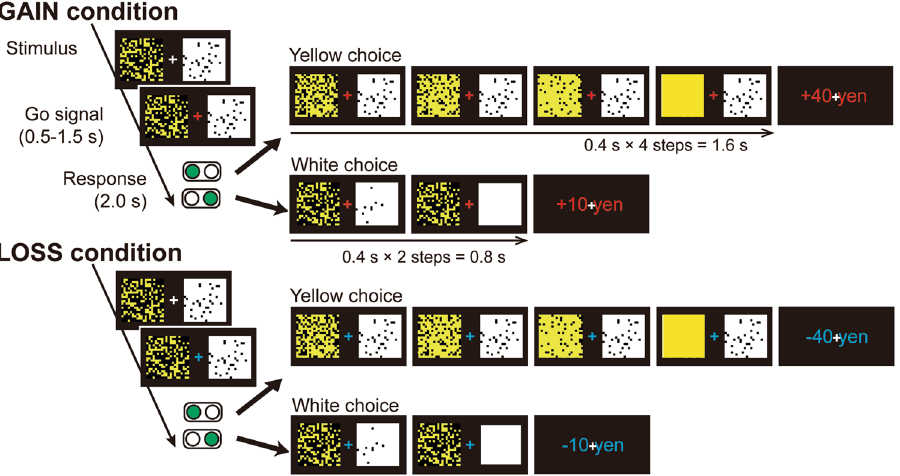
Figure 1. Participants were asked to select either a white or yellow square by pressing a button on the corresponding side. In the example shown, if the participant chose a white square at each step, a small monetary gain (10 yen) in the GAIN condition or a small monetary loss ( − 10 yen) in the LOSS condition was delivered in two steps (0.4 × 2 = 0.8 s). If the participant chose a yellow square, four yellow choices (0.4 × 4 = 1.6 s) had to be repeated to obtain a larger monetary gain (40 yen) in the GAIN condition or a larger monetary loss ( − 40 yen) in the LOSS condition. The position of the squares (left or right) was randomly changed at each